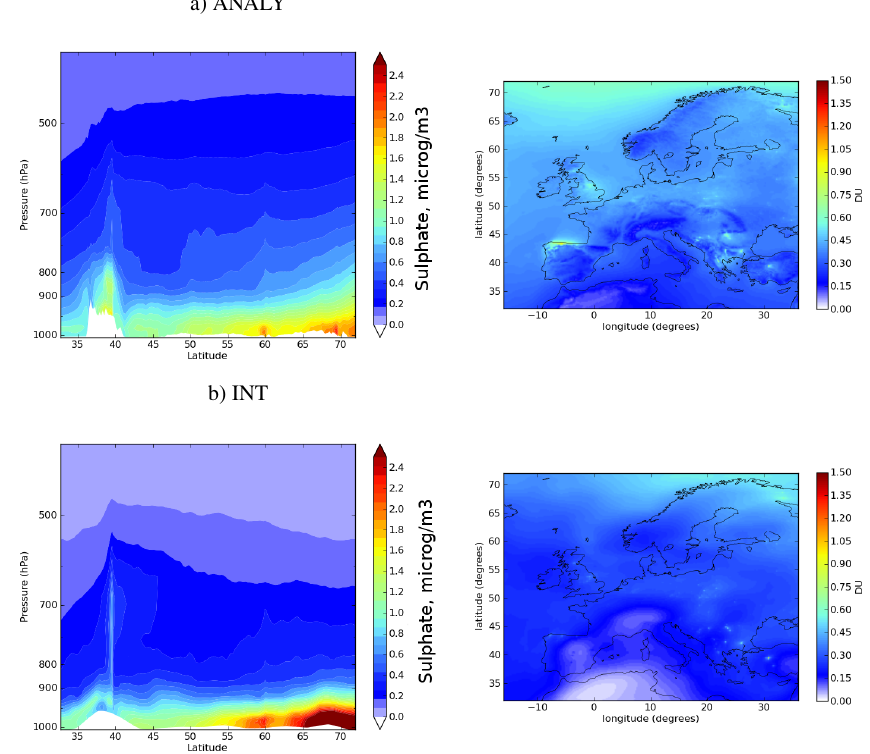
Fig. 4. On the left: latitudinal cross-sections at 30 ◦ E of sulphate concentrations (µg m − 3 ) averaged for the JJAS period. Levels are in hPa. On the right: sulphate column (DU) averaged for the summertime period of ANALY and INT.